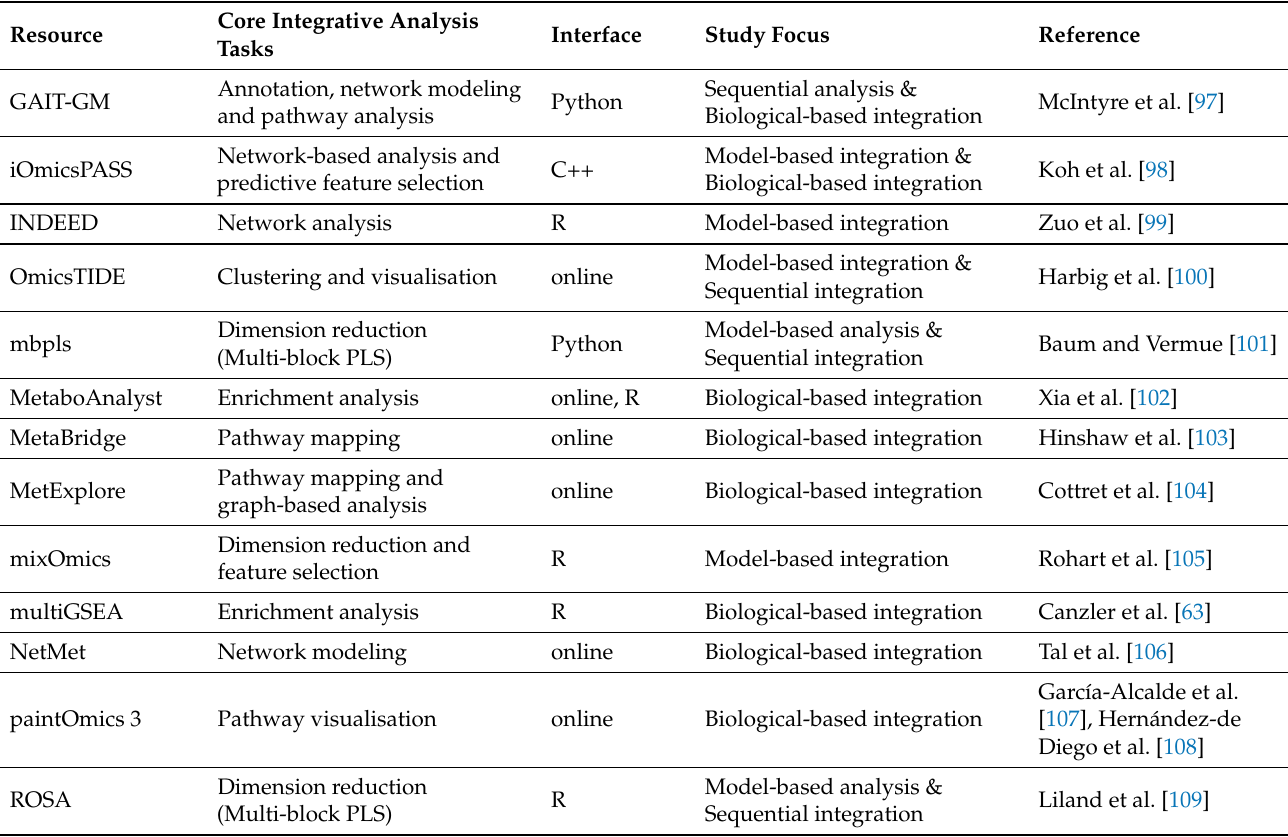
Table 3. Brief overview of some multi-omics tools and techniques supporting integrative analysis in alphabetical order.